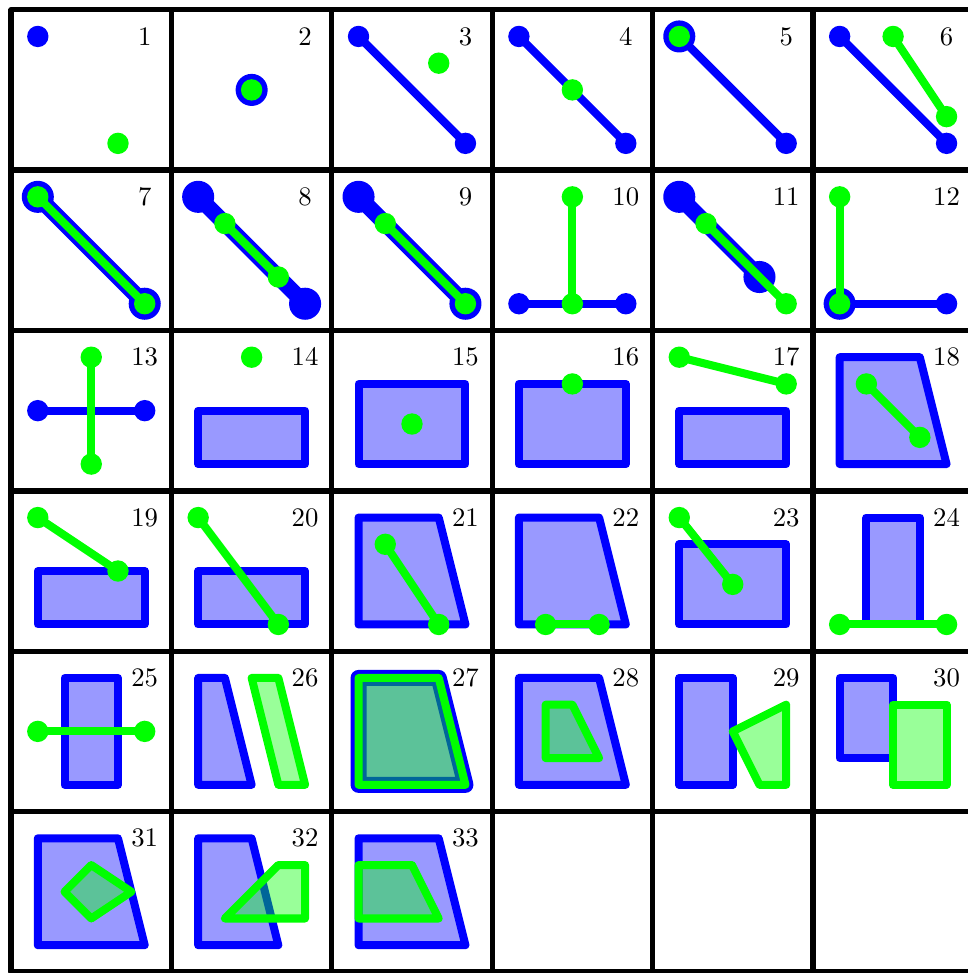
Figure 12. Numbered test cases (simplified